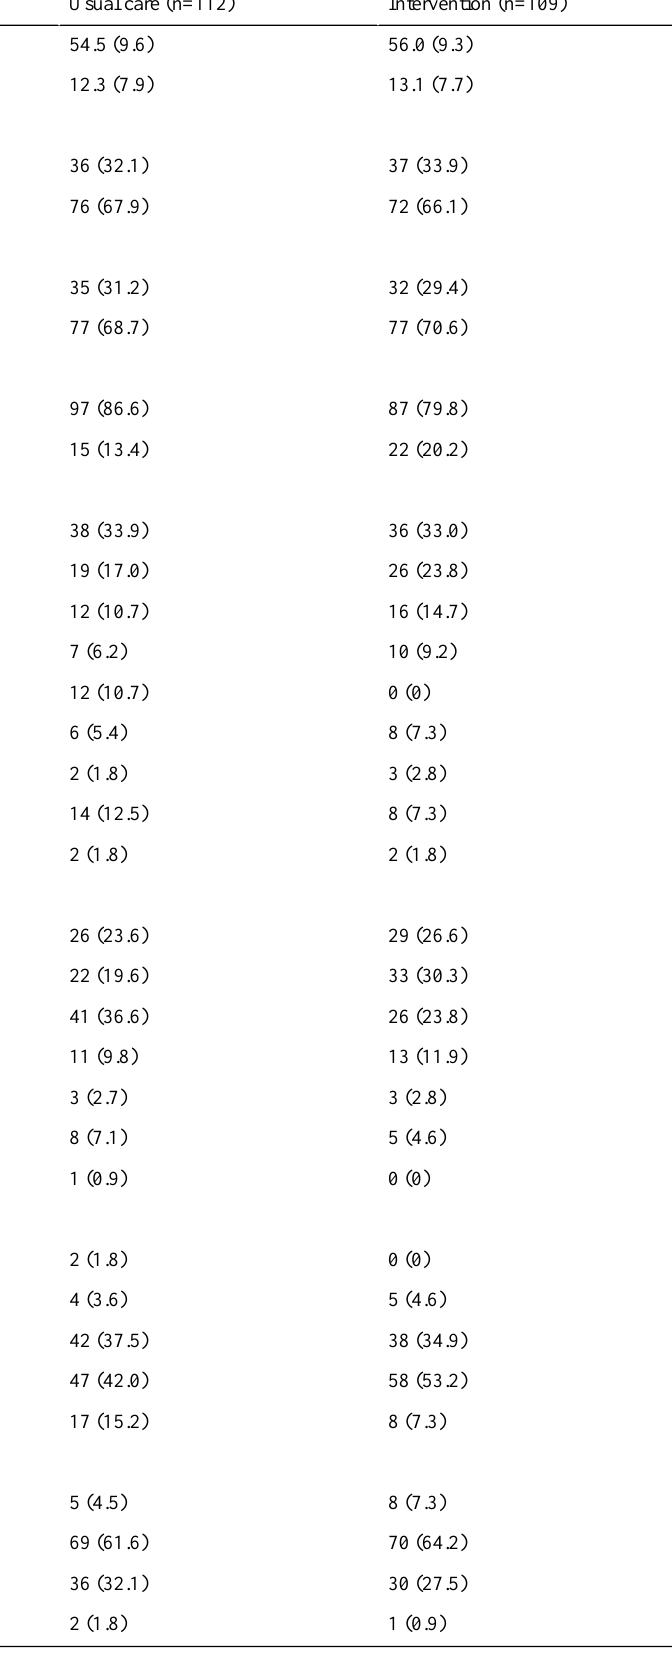
Intervention (n=109)Usual care